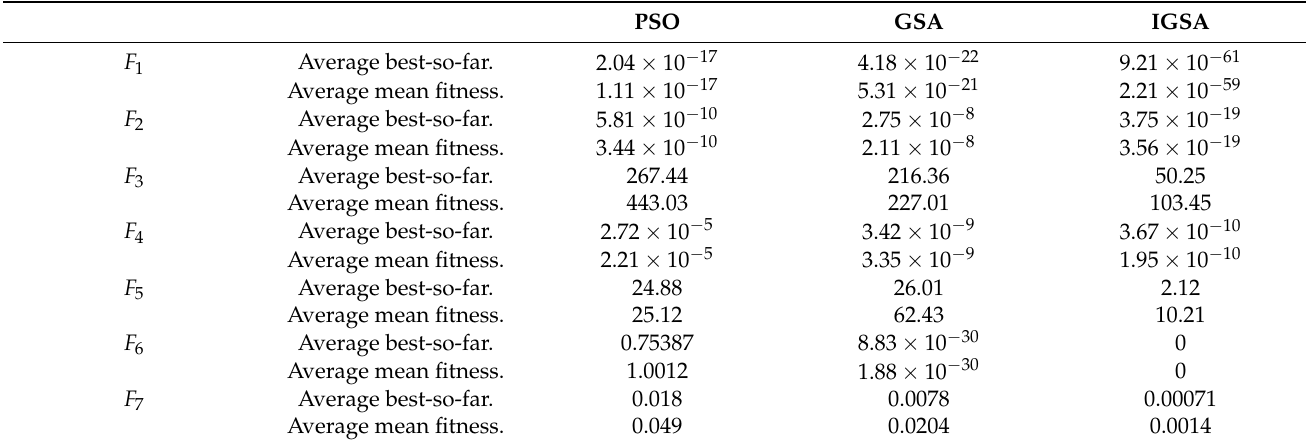
Table 3. Experimental results of unimodal functions.